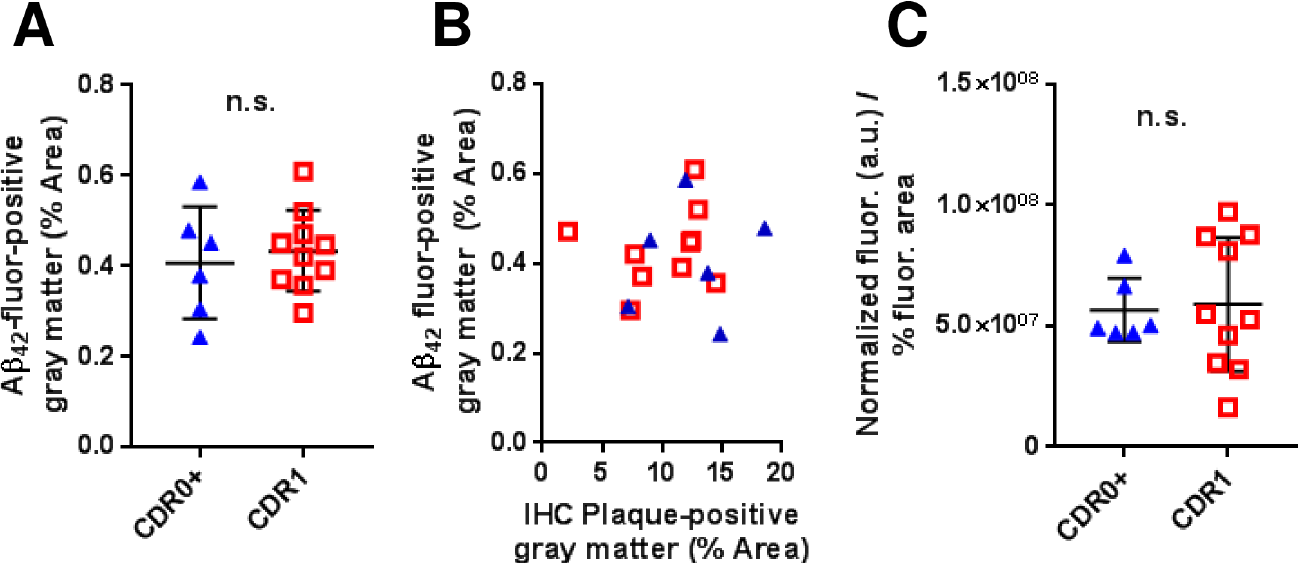
Fig 3. Assessments based on confocal fluorescence microscopy of A β 1-42 -biotin binding does not distinguish between elderly high-pathology controls and elderly subjects with mild ADD. ( A ) Gray matter coverage of fluorescently labelled (streptavidin-Alexa594) A β 1-42 -biotin binding in CDR 0 + plaques group versus CDR 1 group (not significant [n.s.] by Mann–Whitney U test). ( B ) Correlations between fluorescently labelled A β 1-42 -biotin gray matter coverage and overall A β plaque coverage. ( C ) Ratio of the normalized fluorescently labelled A β 1-42 -biotin signal to the percentage fluorescent positive coverage (not significant [n.s.] by Mann–Whitney U test).